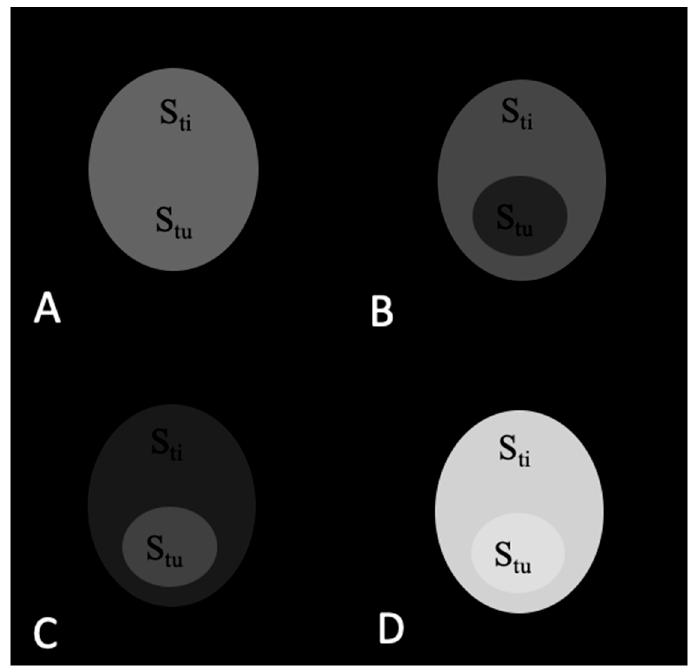
Figure 5. MR images of the tumor phantom model after injection of the T 2 contrast agent. ( A ) T 1 w. ( B ) T 2 w. ( C ) subtracted T 1 w − T 2 w. ( D ) Added T 1 w + T 2 w. The highest TC value is 2.17 in image ( C ).